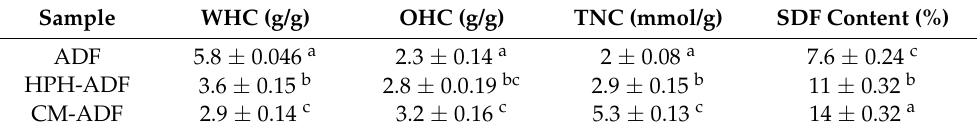
Table 3. Effect of modification on the WHC, OHC, TNC and SDF content of ADF.